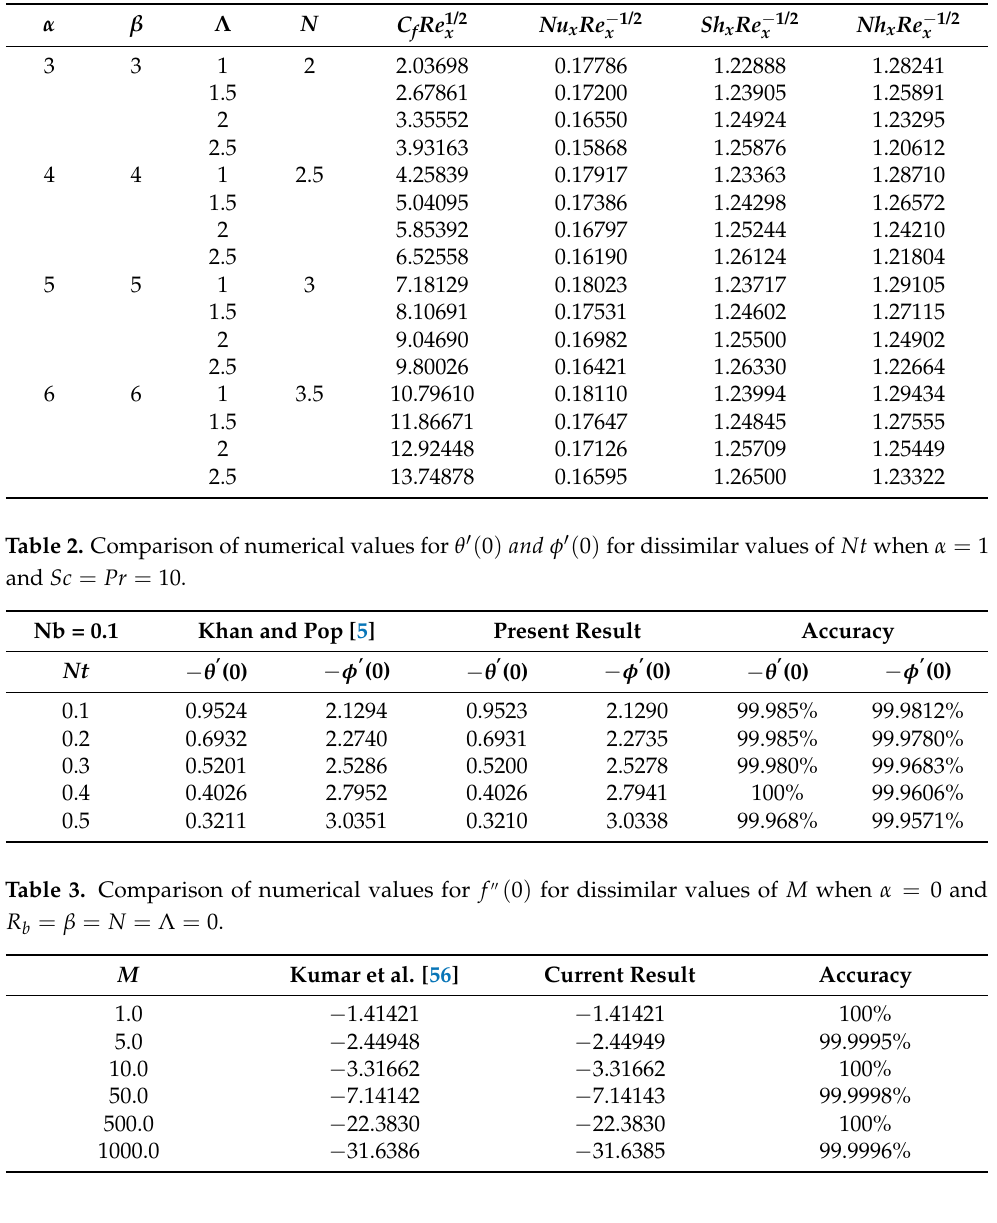
Table 1. Values of friction factor, Nusselt, Sherwood number, and density of microorganism versus for diverse values of Λ when M = 1.0, Pr = 2.0, Nt = 0.1, Nb = 1.5, Sc = 1.0, β = 6.0,